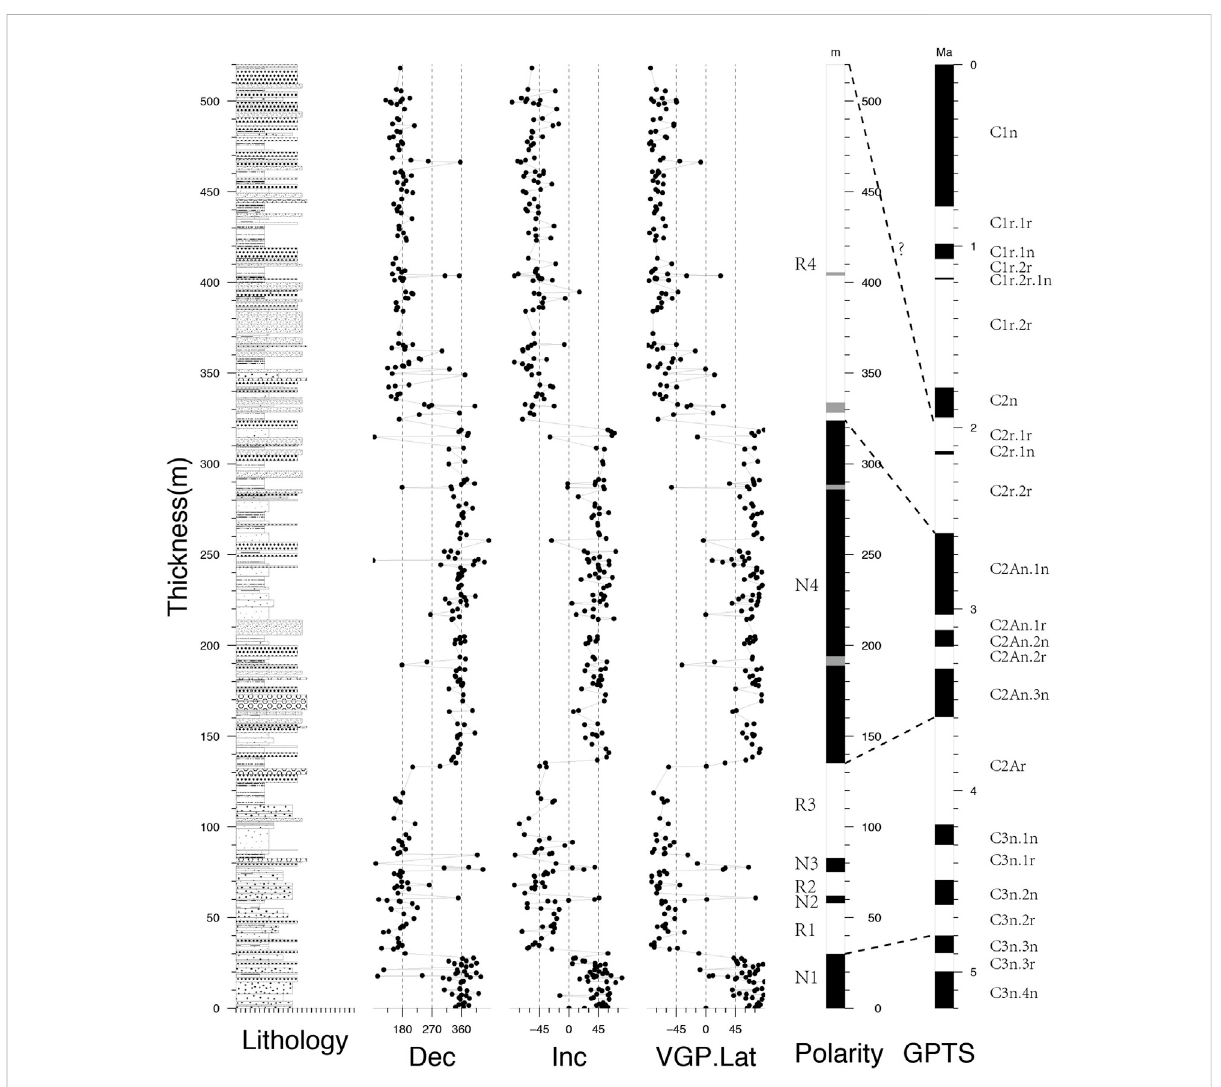
FIGURE 7 LithologyandmagnetostratigraphicresultsfromtheYengisarsectioninthewesternTarimBasin.Thecharacteristicremanencedeclinationand inclination and VGP latitude are plotted as a function of stratigraphic level and the correlation with the geomagnetic polarity time scale (Gradstein et al.,